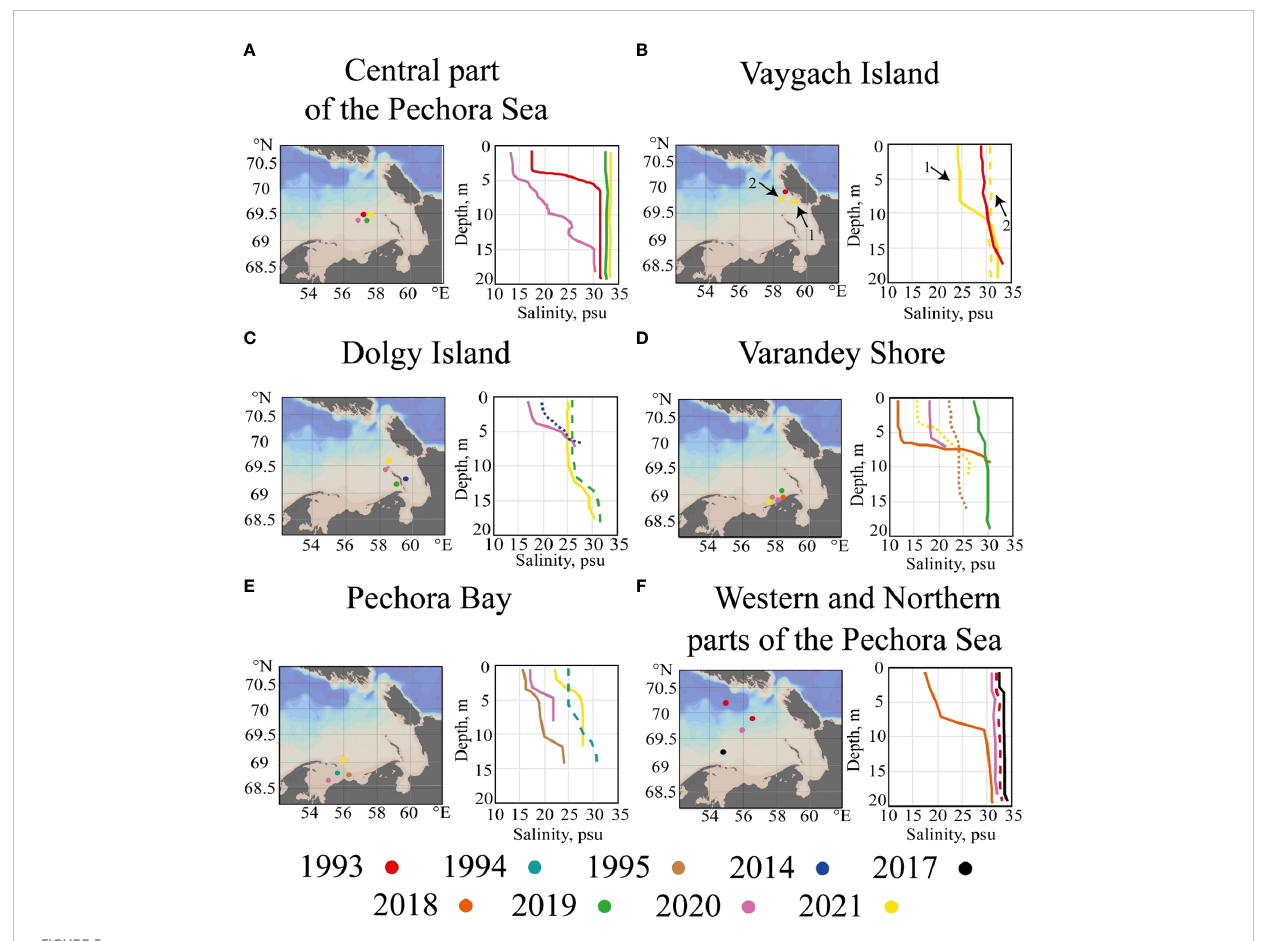
FIGURE 5 Typical vertical salinity structure in the central part of Pechora Sea (A) , near Vaygach Island (B) , Dolgy Island (C) , Varandey shore (D) , in the Pechora Bay (E) , western and northern parts of the Pechora Sea (F) in July-August 1993-1995, 2014, 2017-2021. We used two types of lines (dashed and dotted) for better visibility in case of overlapping stations or matching